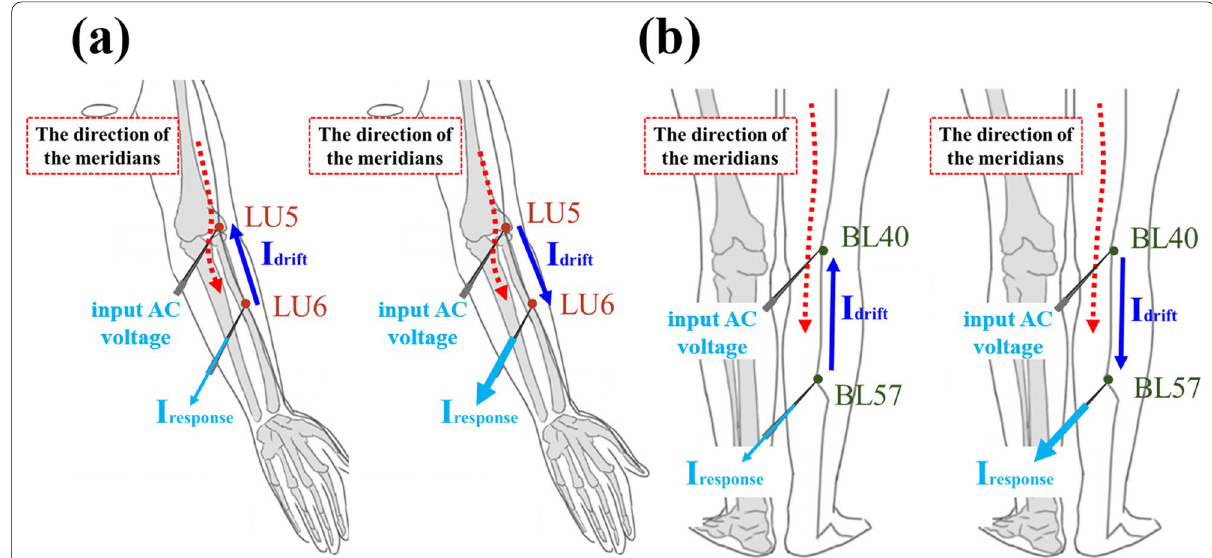
Fig. 10 Relationship between the direction of I drift and the direction of the meridian of a the hand and b the foot. The reverse and the forward relationships between the I drift and the meridian direction caused a decrease and an increase in the I